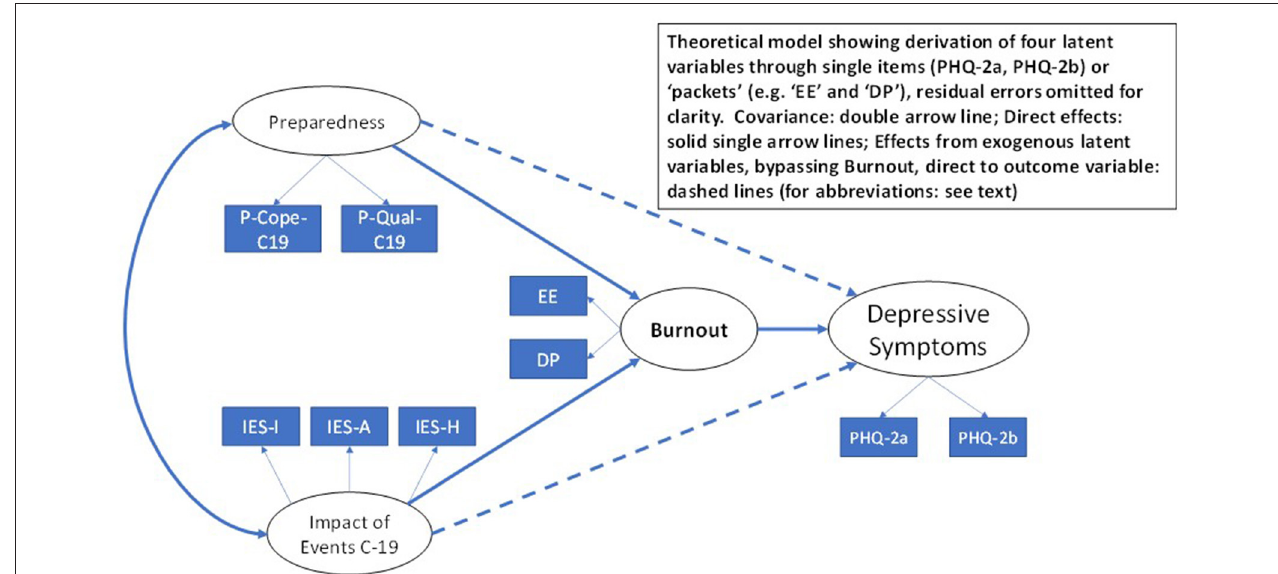
FIGURE 1 | Conceptual